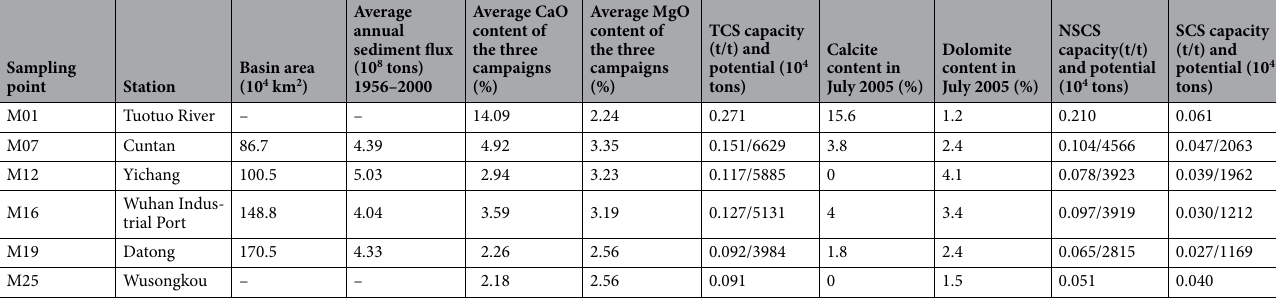
Table 2. The variation of carbon sink capacity and potential of suspended sediment along the Yangtze main